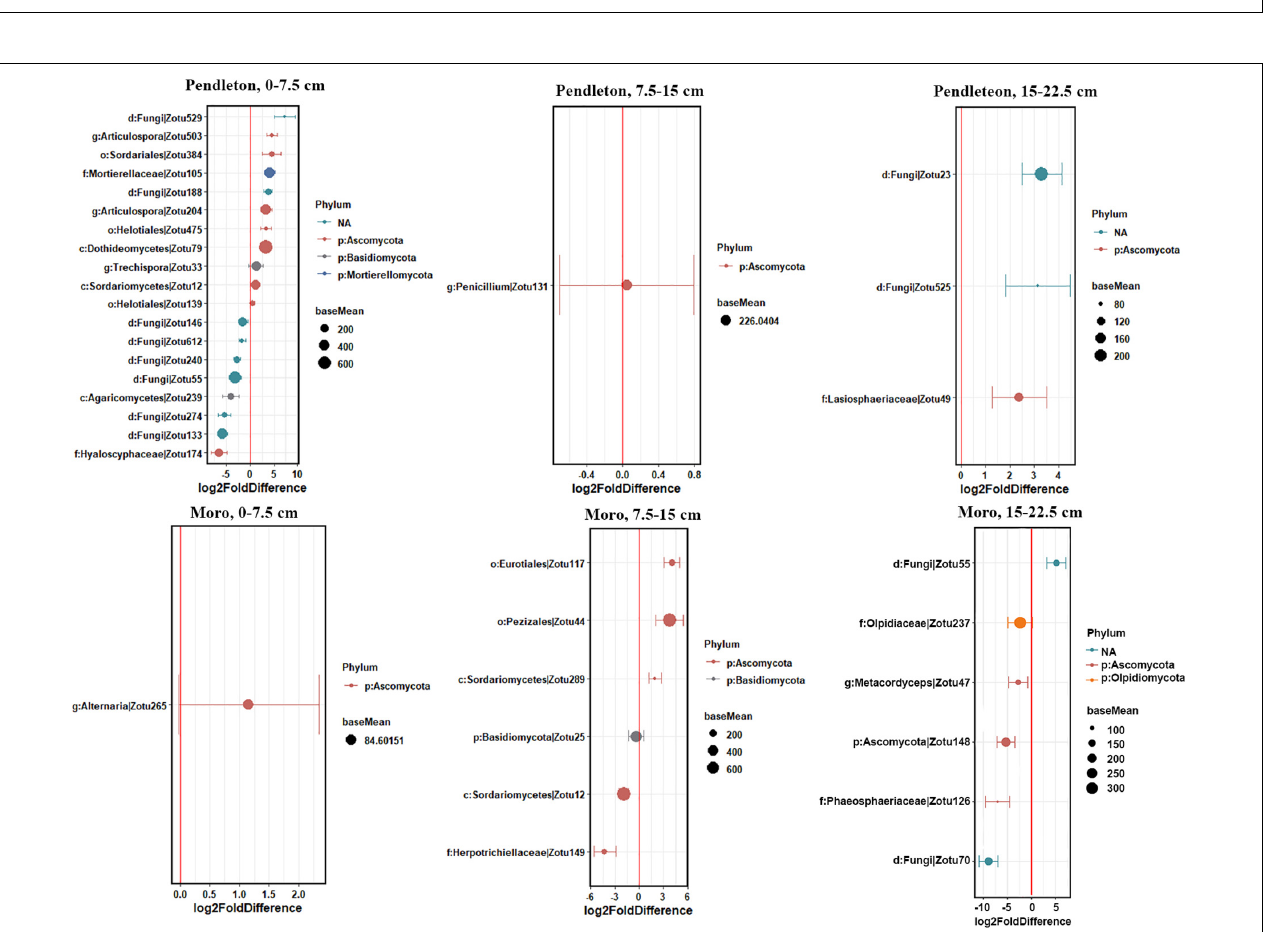
Frontiers in Microbiology |